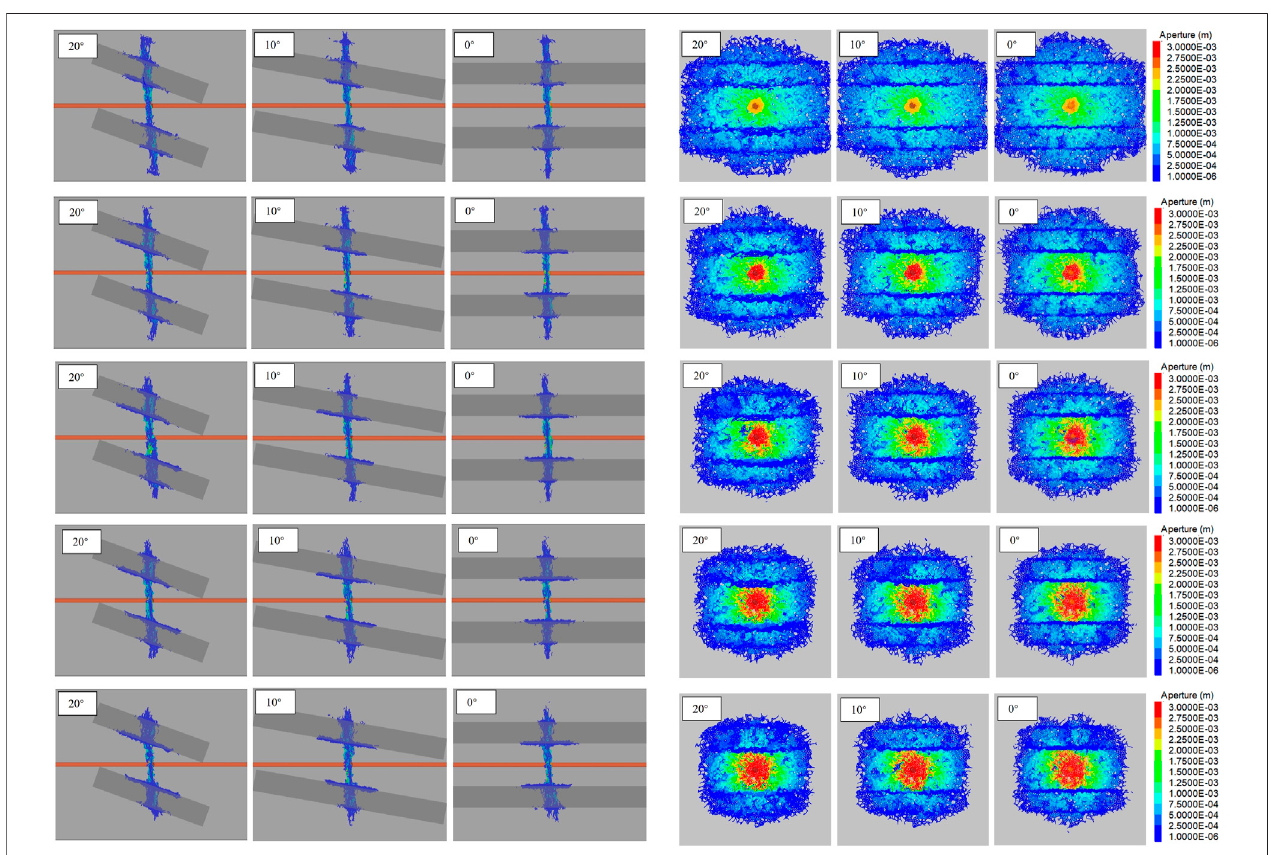
FIGURE 10 | Effects of caprock ’ s inclination and the fl uid injection rate for injection rates of 0.02 m 3 /s, 0.04 m 3 /s, 0.06 m 3 /s, 0.08 m 3 /s, and 0.1 m 3 /s. (A) The model front view, (B) the model side view.